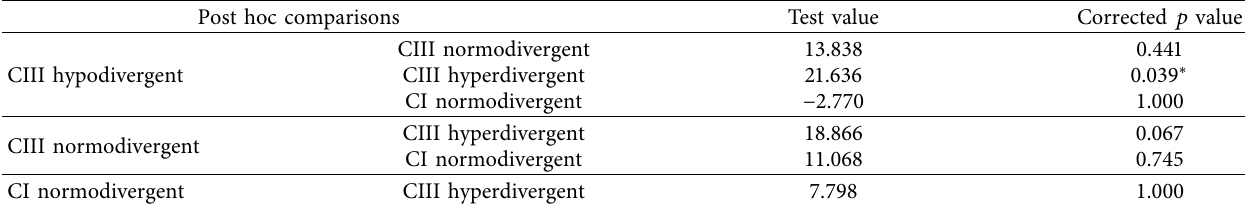
Table 4: The results of significance tests of the mandibular volume between the different studied groups †